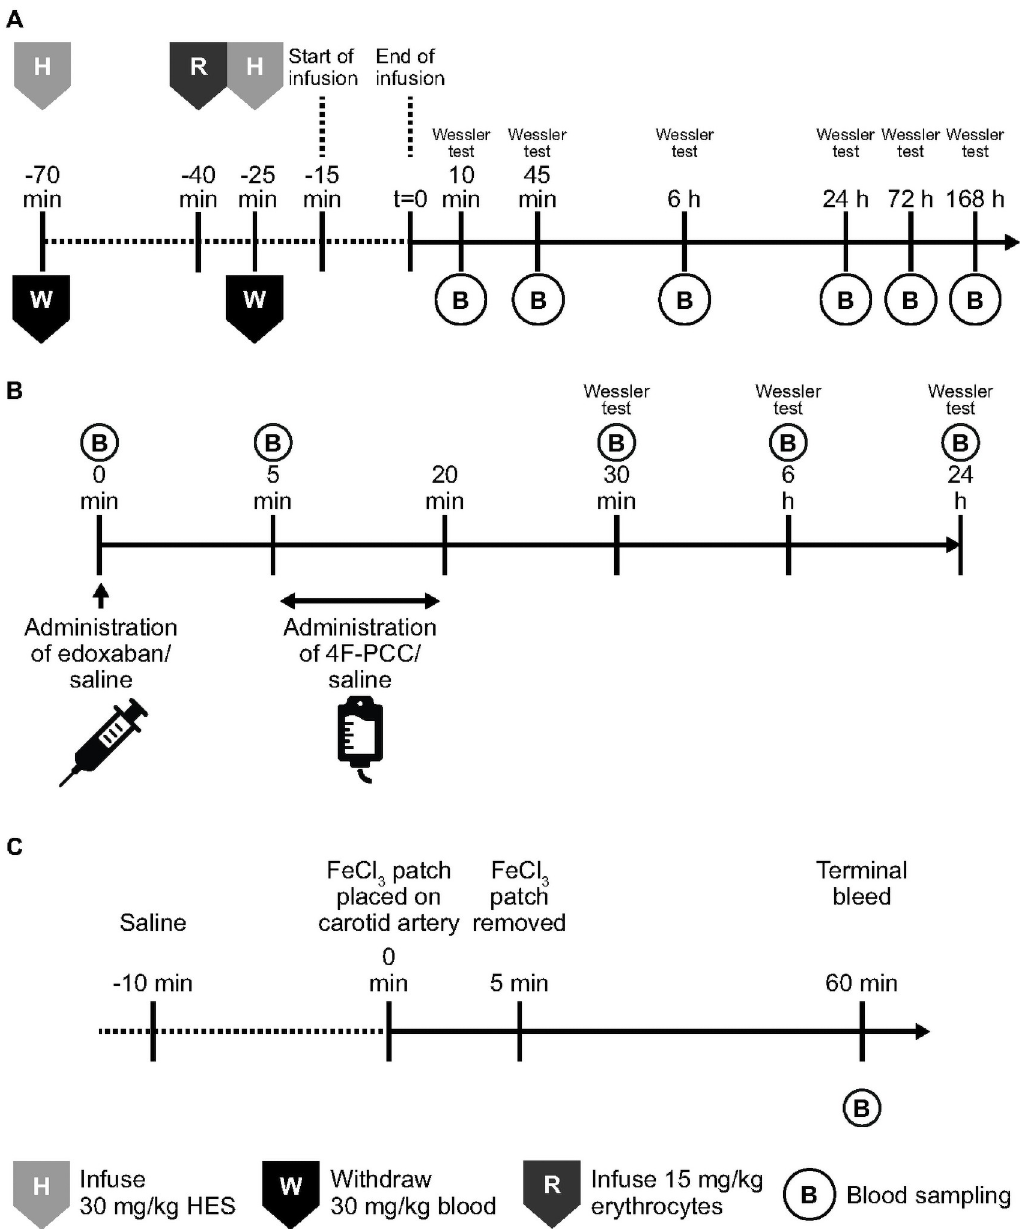
Fig 1. Study schematics. (A) 4F-PCC in rabbits with dilutional coagulopathy, using modified Wessler model of venous stasis- induced thrombosis; (B) 4F-PCC in rabbits with edoxaban-induced coagulopathy using modified Wessler model of venous stasis-induced thrombosis; (C) 4F-PCC in rats, using a ferric chloride-induced model of arterial thrombosis. Haemodilution was used only in the experiments indicated. 4F-PCC, 4-factor prothrombin complex concentrate; h, hours; min, minutes; t, time.